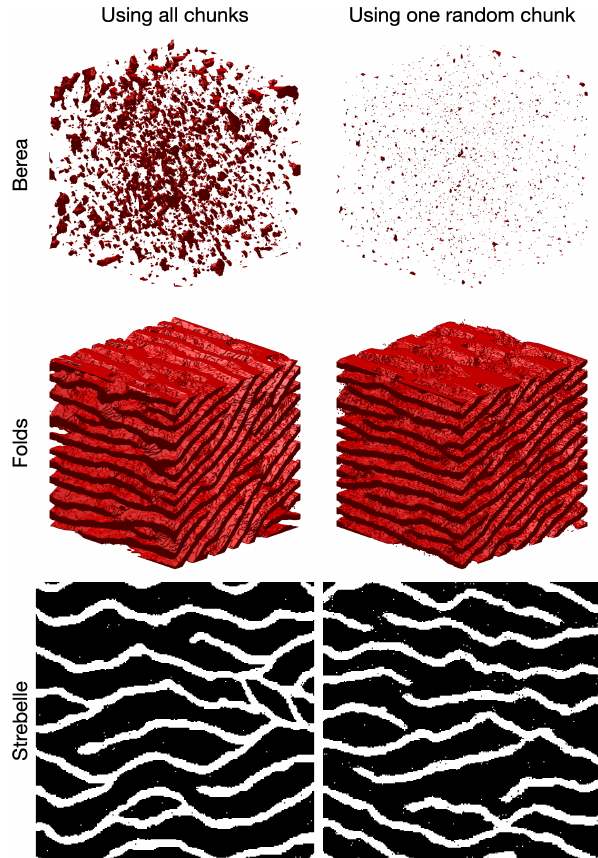
Figure A1. Comparison of QS using the entire training image and using training image splitting. In these examples, the training image is split into two images over each dimension. The original training images are presented in Fig. 2.